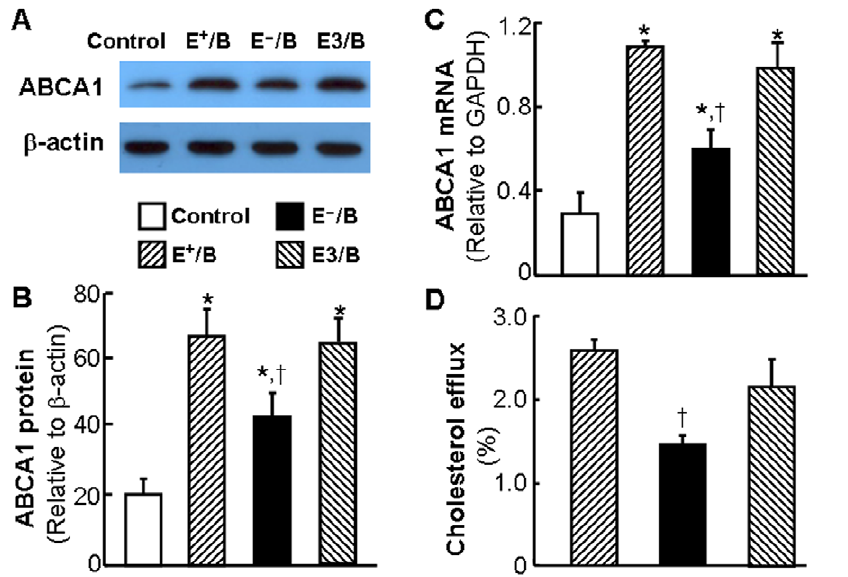
Figure 1. The effect of ApoE on lipoprotein-induced ABCA1 expression and cholesterol efflux. For study the effect of ApoB-carrying lipoproteins on ABCA1 expression, mouse macrophages were incubated with 20 m g/ml of wild-type (E + /B), ApoE-free (EIˆ/B) or ApoE3-enriched (E3/B) lipoproteins, or culture medium alone. Panel A and B: The level of ABCA1 protein was determined by western blot analysis and quantitated relative to b -actin. Panel C: The level of ABCA1 mRNA was determined by quantitative real-time RT-PCR and normalized to GAPDH mRNA. Panel D: For studying the effect of ApoE on lipoprotein-induced cholesterol efflux, mouse macrophages were incubated with [ 3 H]-cholesterol in the presence or absence of 20 m g/ml of E + /B, E 2 /B or E3/B lipoproteins. ApoAI-mediated cholesterol efflux was measured as described under Materials and Methods. Values represent the mean 6 SEM of five independent experiments. Differences among cells treated with E + /B, E 2 /B, E3/B lipoproteins or culture medium alone were analyzed by one-way ANOVA followed by Tukey post-hoc tests (B and C) or Student t -test (D). * P , 0.05 compared to control, { P , 0.05 compared to E + /B or E3/B lipoprotein treatment.